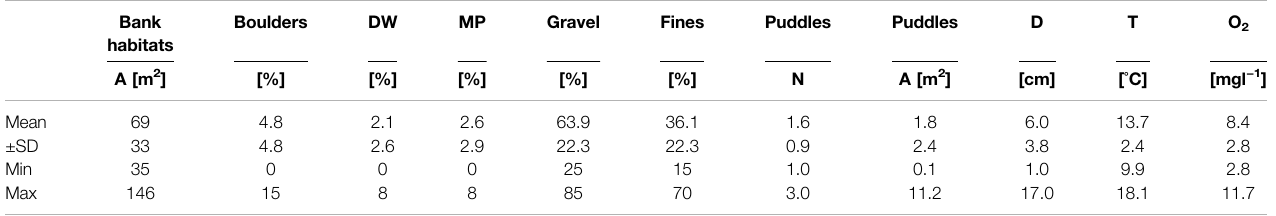
TABLE 1 | Habitat description of the dewatered bank habitats in the Hammerbach. Bank habitats